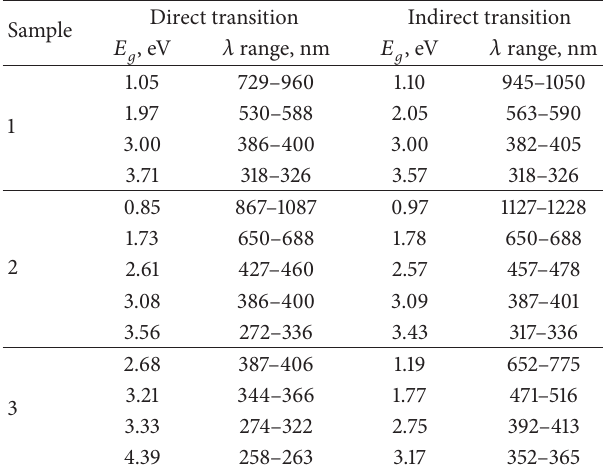
Table 2: The band gap energies of samples and the corresponding wavelengths.